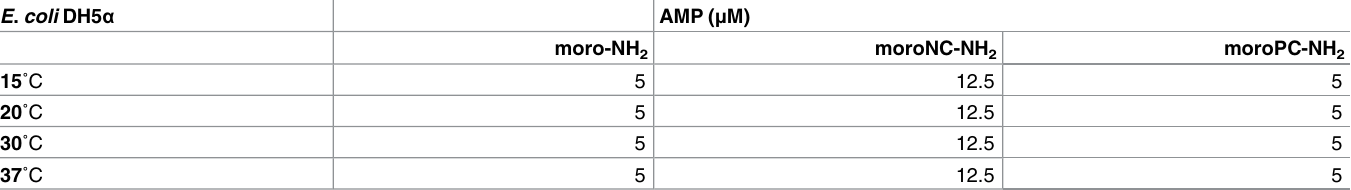
Table 5. Effect of temperature on AMP activity against E. coli DH5 α .